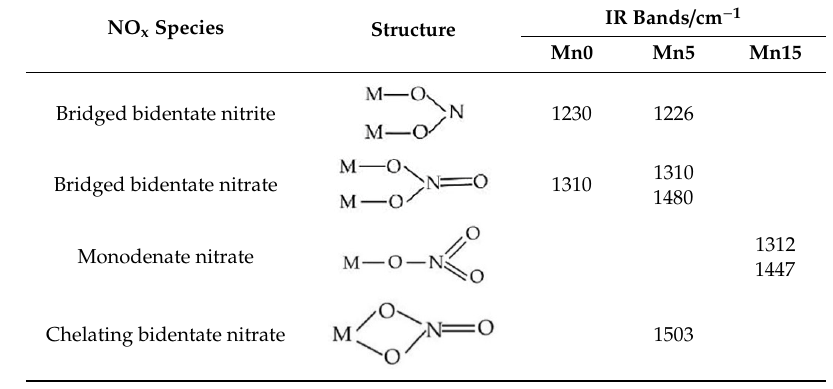
Figure 9. In situ DRIFTS spectra of NO x adsorption on Mn15 sample at 150 °C ( a ), 200 °C ( b ), 250 °C ( c ), 300 °C ( d ), 350 °C ( e ). Table 6. Characteristic vibrations of adsorbed NO x species on Mn0, Mn5, Mn15 catalysts. Table 7. Characteristic vibrations of adsorbed NO x species on Mn15 catalyst.